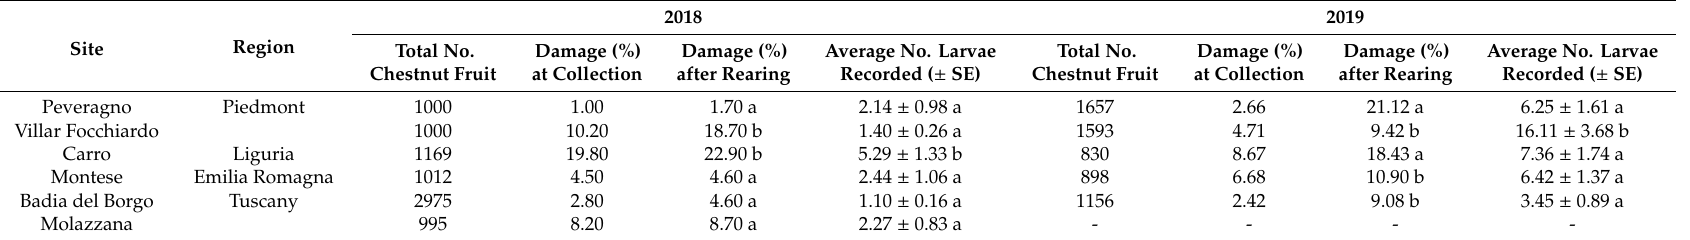
Table 4. Total number of chestnut fruits collected per site and region, and percentage of damage recorded at collection and after storage in the two-year period